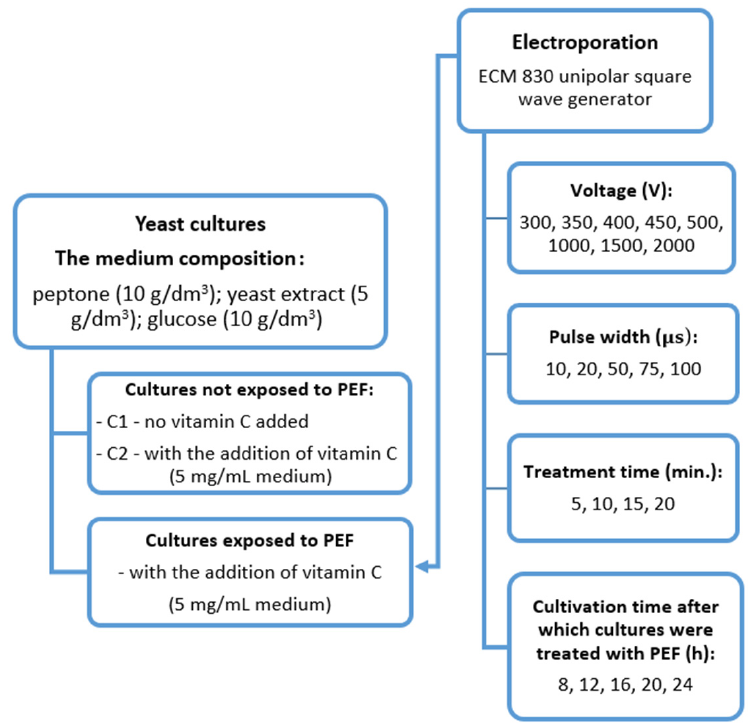
Figure 1. Scheme of optimization of the PEF parameters.